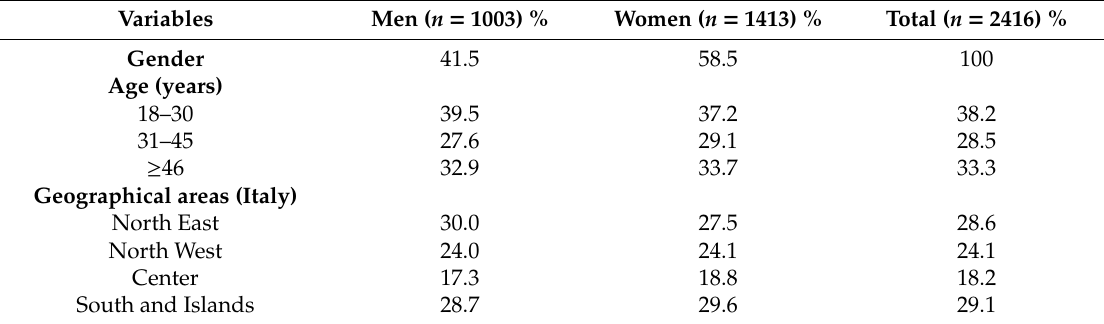
Table 2. Characteristics of the participants.